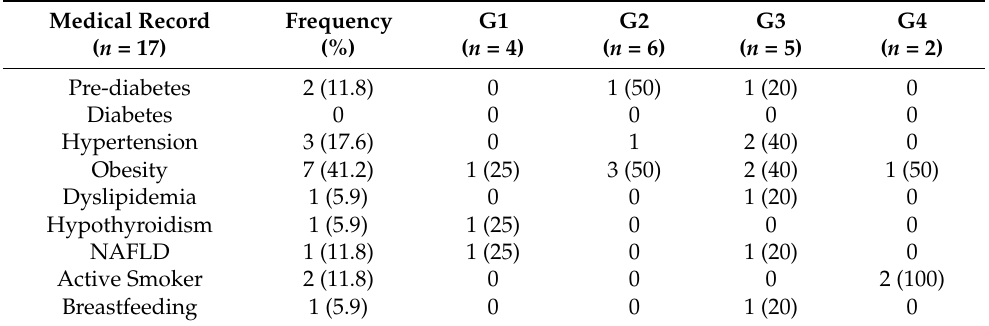
Table 1. Medical